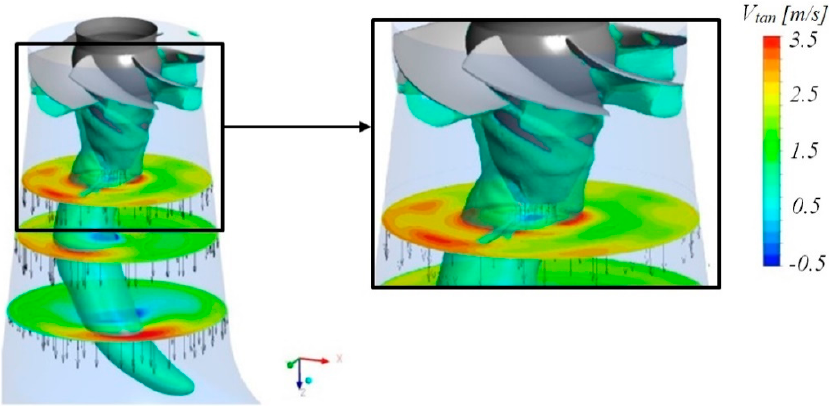
Figure 14. Iso-pressure contour of the rotating vortex rope (RVR) in the draft tube of a Kaplan turbine model during PL operation. Tangential velocity contours are presented for Sections I, II and III (see Figure 3).